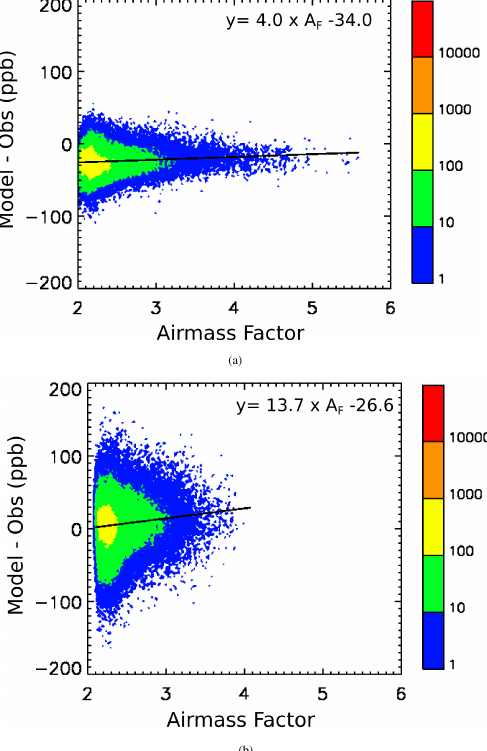
Fig. 9. Linear regression for SU 1 posterior state (model) minus TANSO-FTS observations (a) or SCIAMACHY observations (b) as a function of the air mass factor ( A F